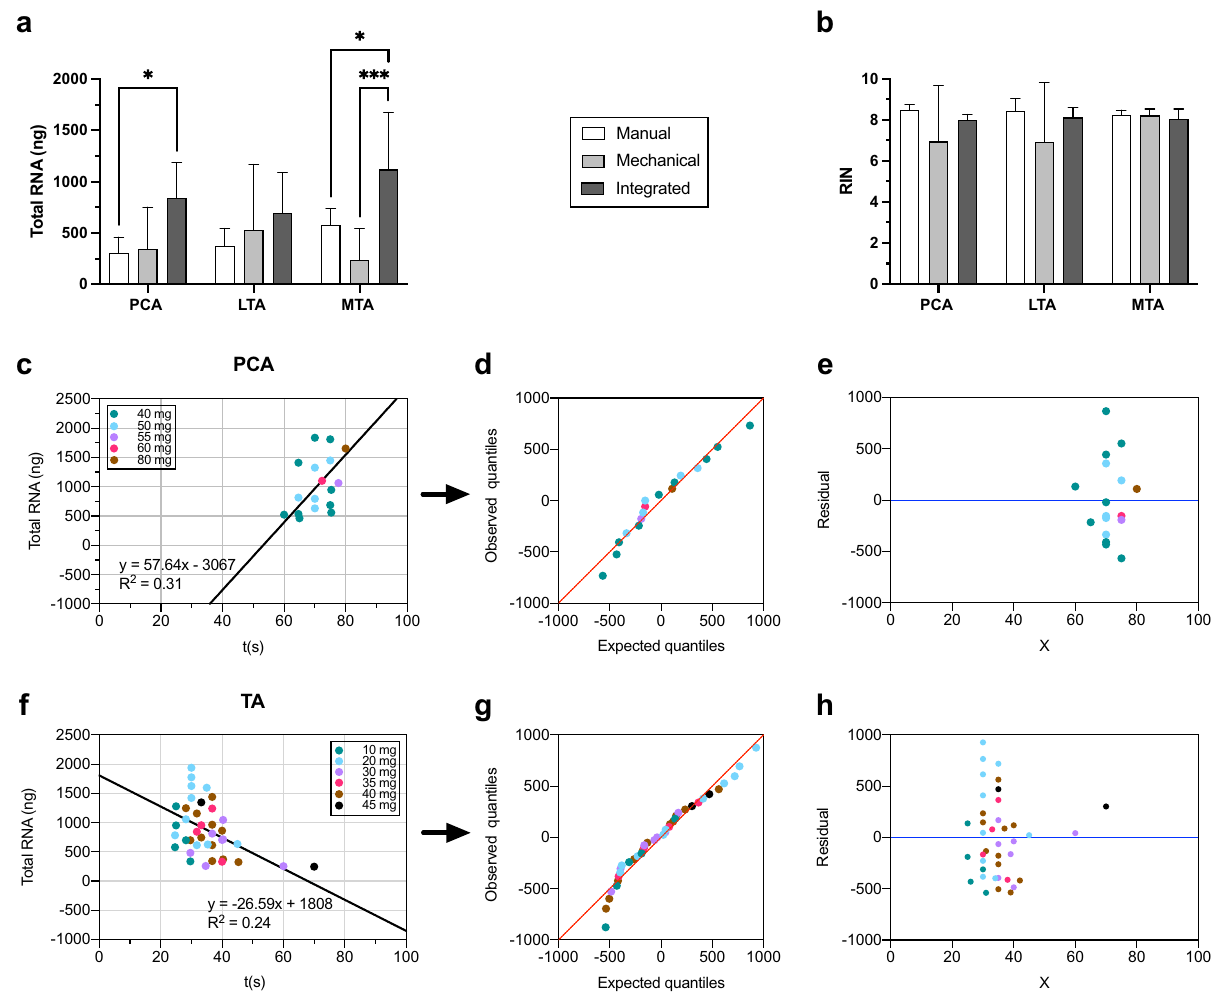
Figure 3. The impact of the novel disruption paradigm on RNA recovery. Total RNA (ng) was determined by computing the volume of the RNA elution buffer (38 µL) and the RNA concentration (ng/µL) measured via a Nanodrop Spectrophotometer at 260 nm. ( a ) Comparison of the total RNA extraction (per respective ILM) between the integrated method (experimental) (PCA, N = 6; LTA, N = 6; MTA, N = 6) relative to the manual and mechanical techniques (PCA, N = 6; LTA, N = 6; MTA, N = 6). ( b ) RIN values were obtained using different homogenization methods. The Agilent 2100 Bioanalyzer Pico Chip assay indicated the RNA stability of extracts. ( c , f ) Linear regression analysis correlating disruption time, tissue weight, and total RNA recovery from ( c ) PCA (m = 57.64, R 2 = 0.31) and ( f ) TA muscles (m = − 26.59, R 2 = 0.24). ( d , g ) Q-Q plot of the weight distribution in the PCA ( d ) and TA ( g ) muscles. ( e , h ) Residual analysis for validation of the linear regression in the PCA ( e ) and TA ( h ) muscles. Analysis of variance was performed using a two-way ANOVA with Posthoc tests. The data is expressed as mean ± SD. * means P < 0.05; ** P < 0.01; *** P < 0.001; **** P <